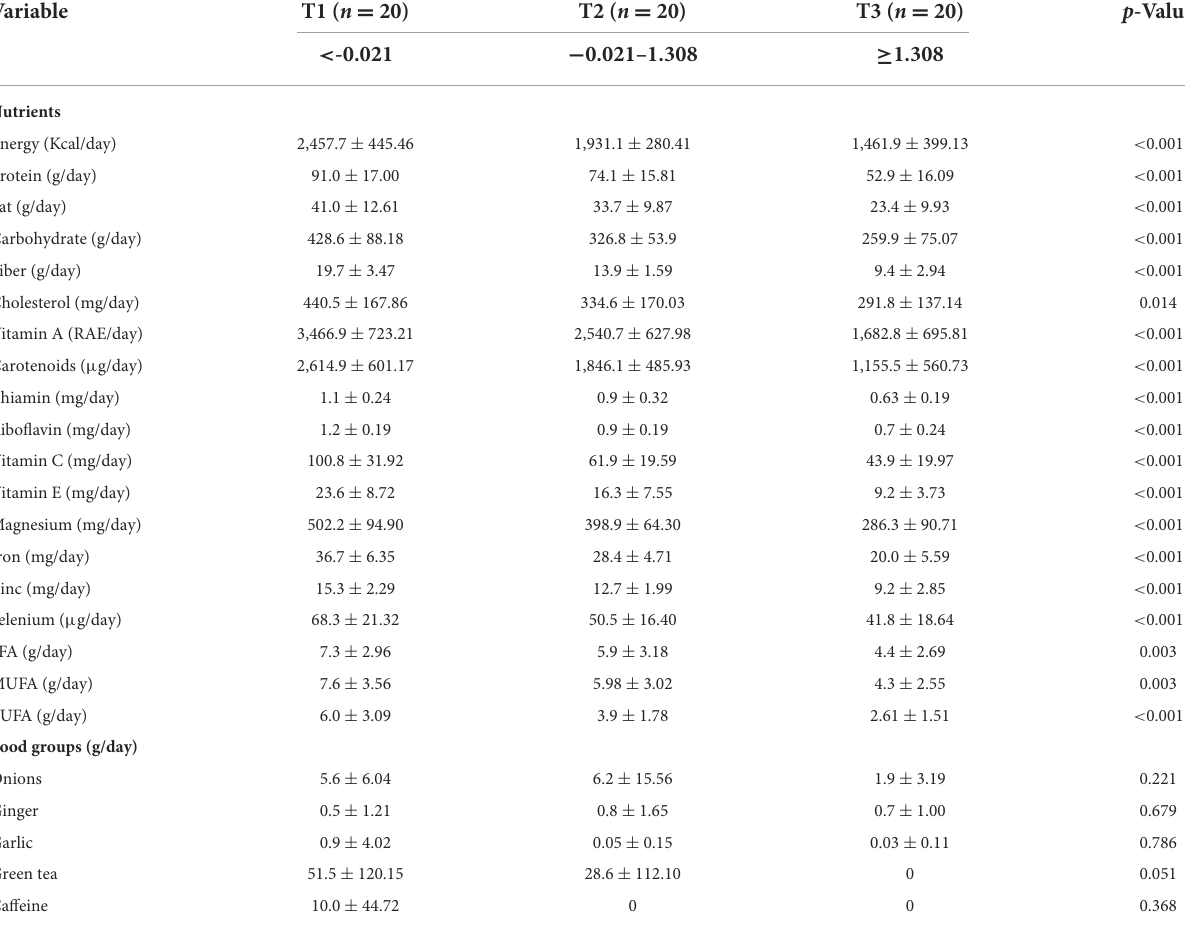
TABLE 3 Food group and nutrient intake of AD patients in different inflammatory diet groups.